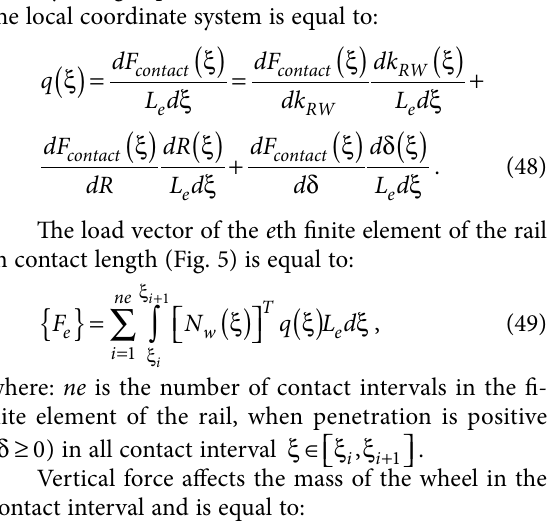
Fig. 5. Wheel and rail geometric parameters for the contact